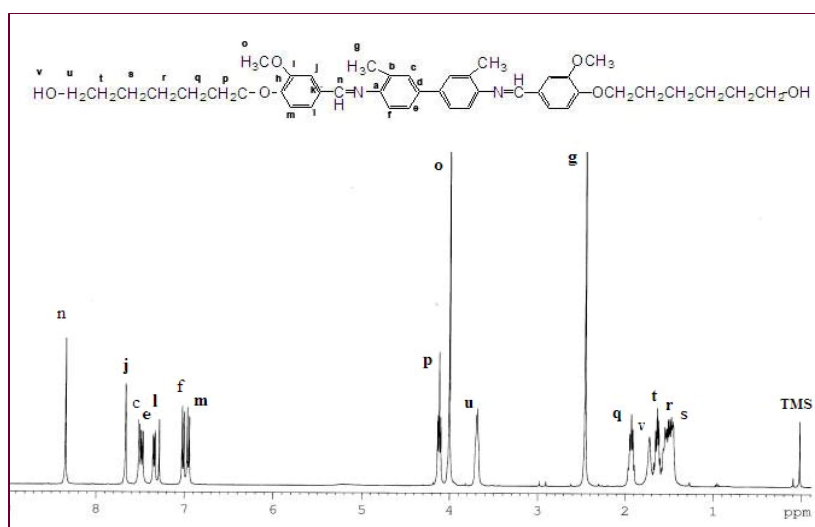
Figure 1. 1 H-NMR spectrum of Ia .